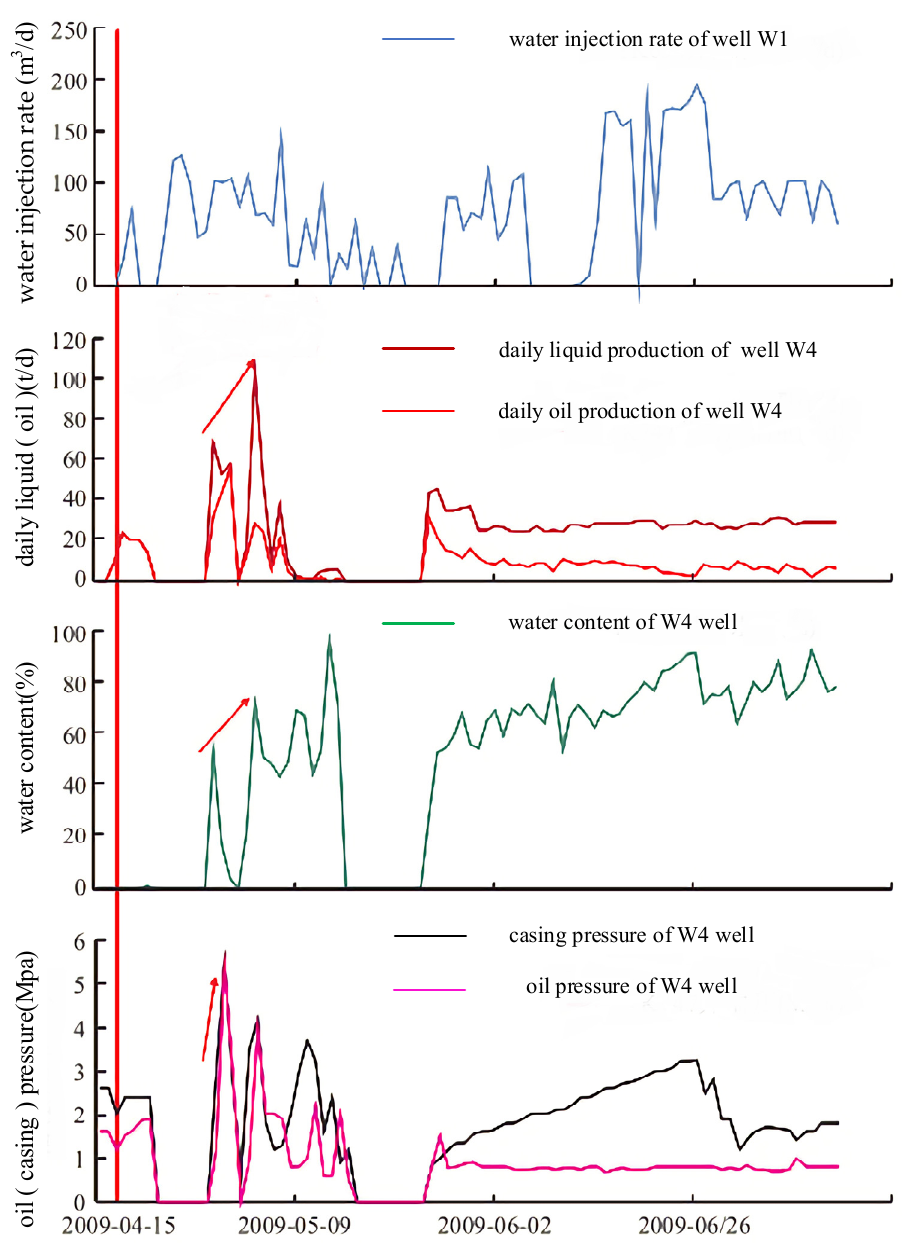
Figure 7. The production curve of W4 well after W1 water injection.